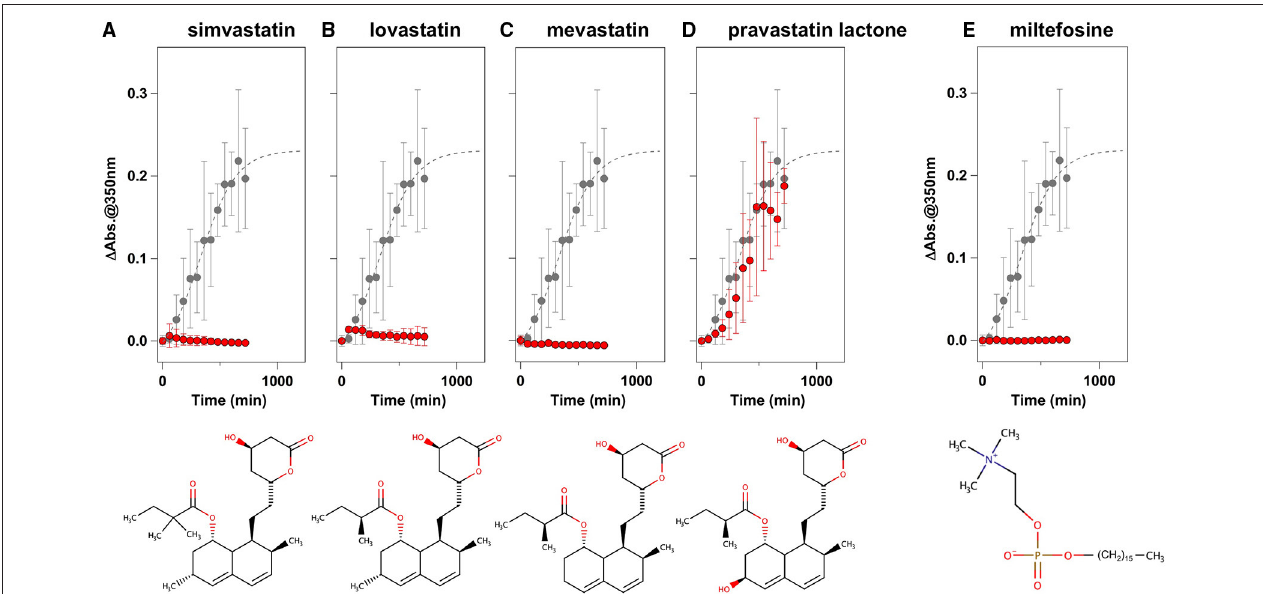
FIGURE 2 | Statins and miltefosine as potent inhibitors for the formation of insoluble apo-SOD1(G37R) S-S aggregates. (A–E) The turbidity increase of 20 µ M apo-SOD1(G37R) S - S in the presence of 1MGdn is shown in the presence of the following compounds (red filled circles): (A) simvastatin, (B) lovastatin, (C) mevastatin, (D) pravastatin lactone, and (E) miltefosine. In each panel, the aggregation kinetics without any drugs was shown as gray filled circles. The kinetics was monitored by changes in the solution turbidity (the absorbance at 350nm), and the final concentration of drugs added was 20 µ g/mL. Experiments were repeated more than three times to estimate error bars (standard deviation). Structures of the chemical compounds were also shown below the